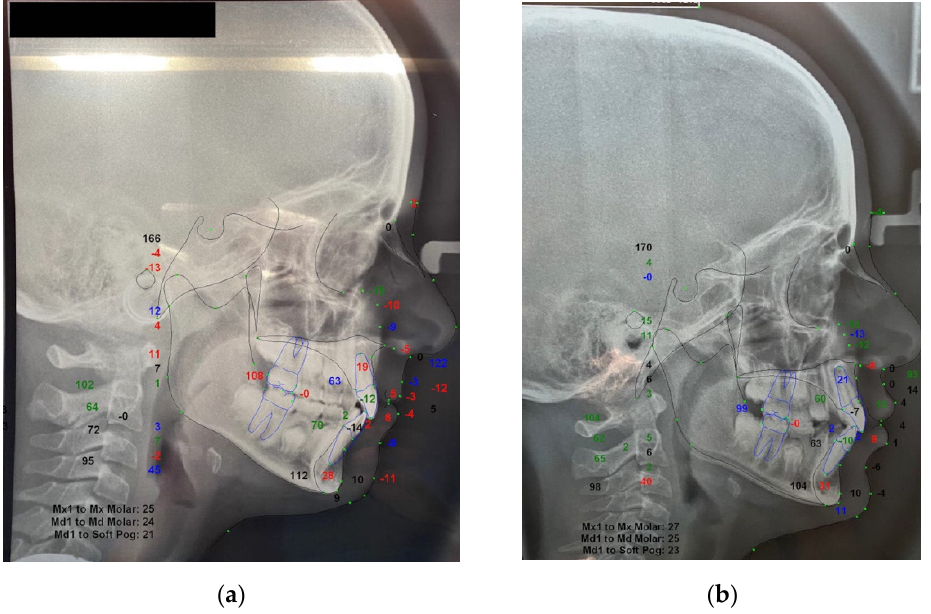
Figure 2. Comparative evaluation of cephalometric analysis performed at T0 ( a ) and T1 ( b ) to identify potential skeletal and dentoalveolar changes in sagittal and vertical relation.